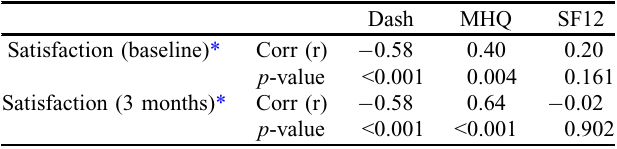
Table 3. Instrument scores correlation with Satisfaction – baseline and 3-month